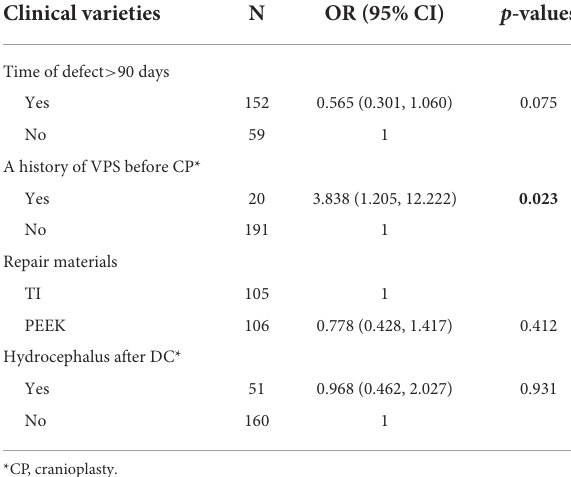
TABLE 5 Multivariate logistics regression analysis on postoperative overall complication.